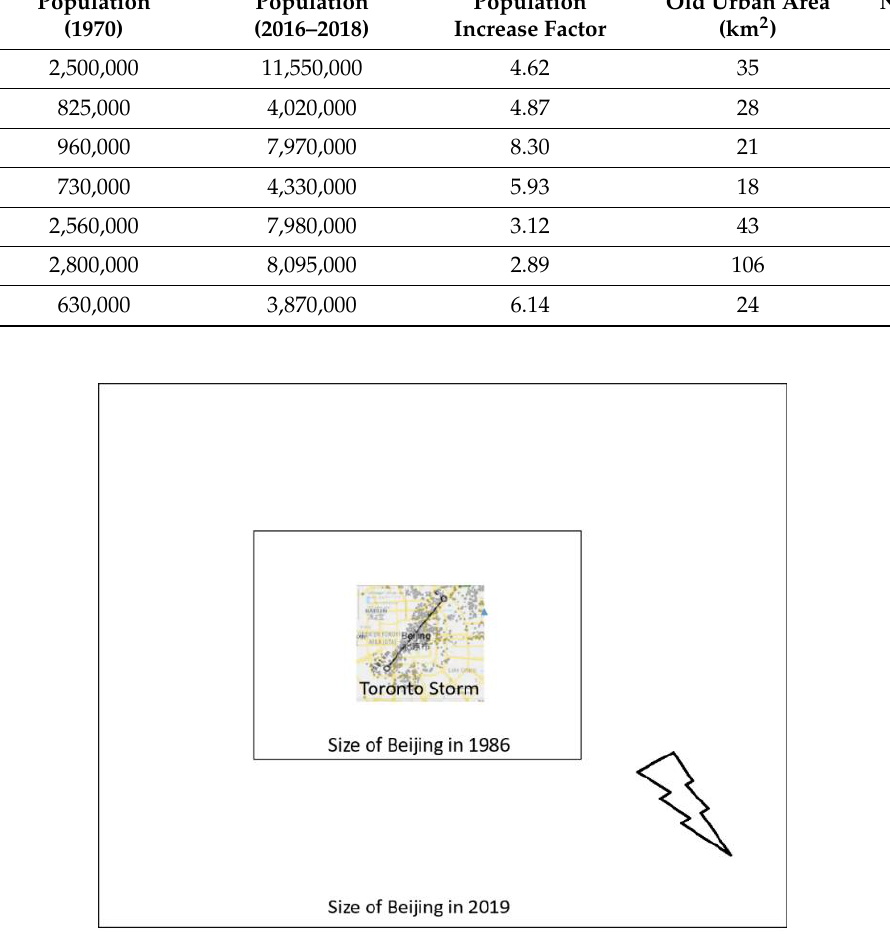
Figure 4. Toronto (Canada) storm of 2013 overlain on Beijing, China.